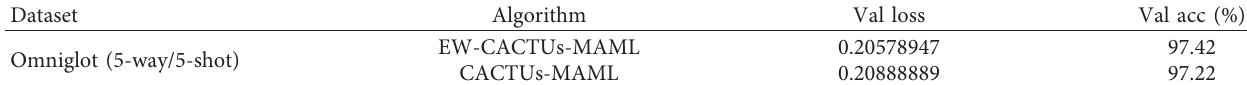
Table 1: Results of experiments with k � 500 for each partition.